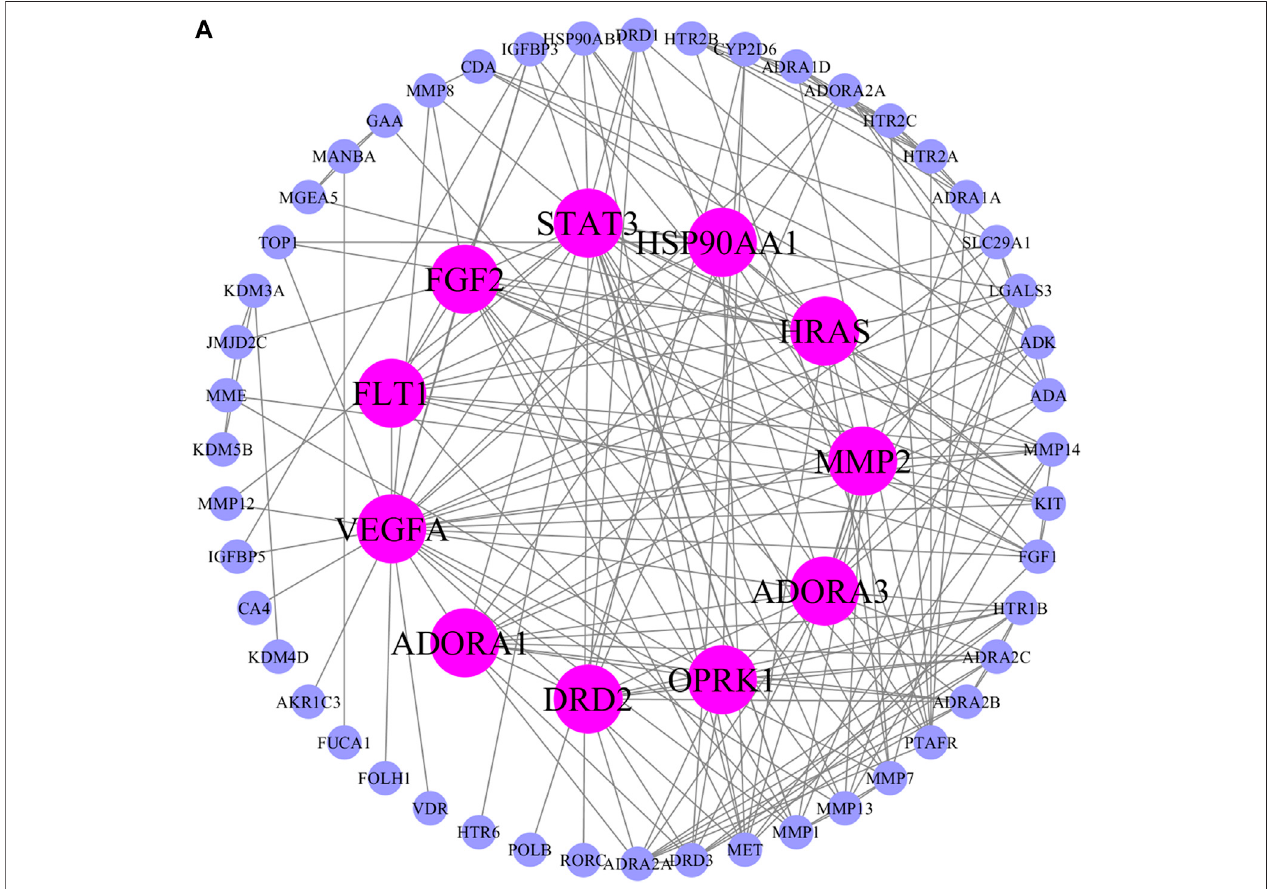
FIGURE 4 | Protein-protein interaction network of potential AA targets. The pink nodes represent proteins with strong interaction potential. The blue nodes in the periphery represent proteins with weak interaction potential.